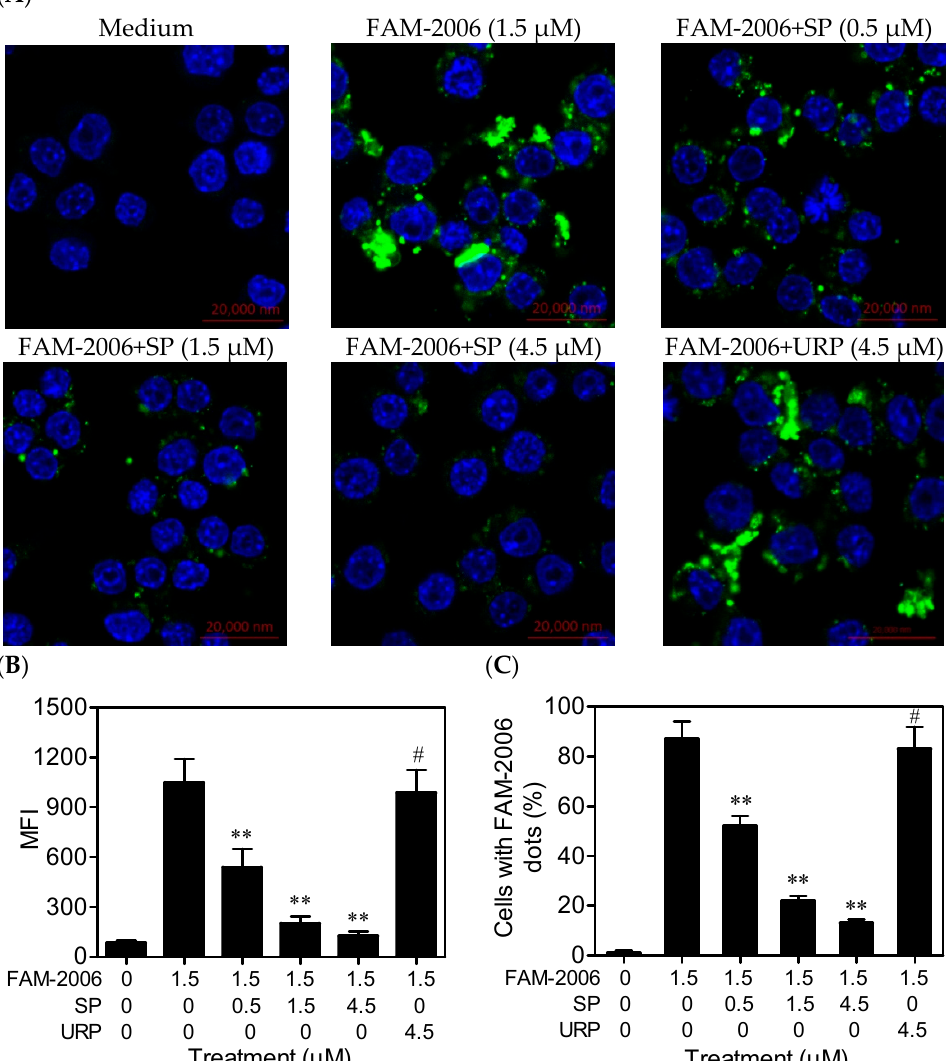
Figure 5. Synthetic peptide (SP) inhibited ODN2006 internalization, as assessed using laser confocal scanning (Scale bar = 20 μ m). RAW264.7 cells (1 × 10 6 cells) grown on 2-cm glass bottom dishes were treated with normal medium, 1.5 μ M of FAM-labeled ODN2006 (FAM-2006) that had been preincubated with SP (0, 0.5, 1.5 or 4.5 μ M) or unrelated peptide (URP; 4.5 μ M) at 37 °C for 15 min. After treatment for 30 min, cells were washed with warm phosphate buffered saline (PBS) and fixed with 4% ( m / v ) paraformaldehyde, then stained with DAPI (4 ′ ,6-diamidino-2-phenylindole) (blue). The intracellular FAM-2006 (green) was observed using a laser confocal microscope ( A ) ; Mean fluorescence intensity (MFI) values ( B ) and the percentages of cells with FAM-2006 dots (green fluorescence) ( C ) were calculated by the ZENlite 2012 software ( n = 100). “**”, p < 0.01; “#”, p > 0.05 vs. FAM-2006 alone.